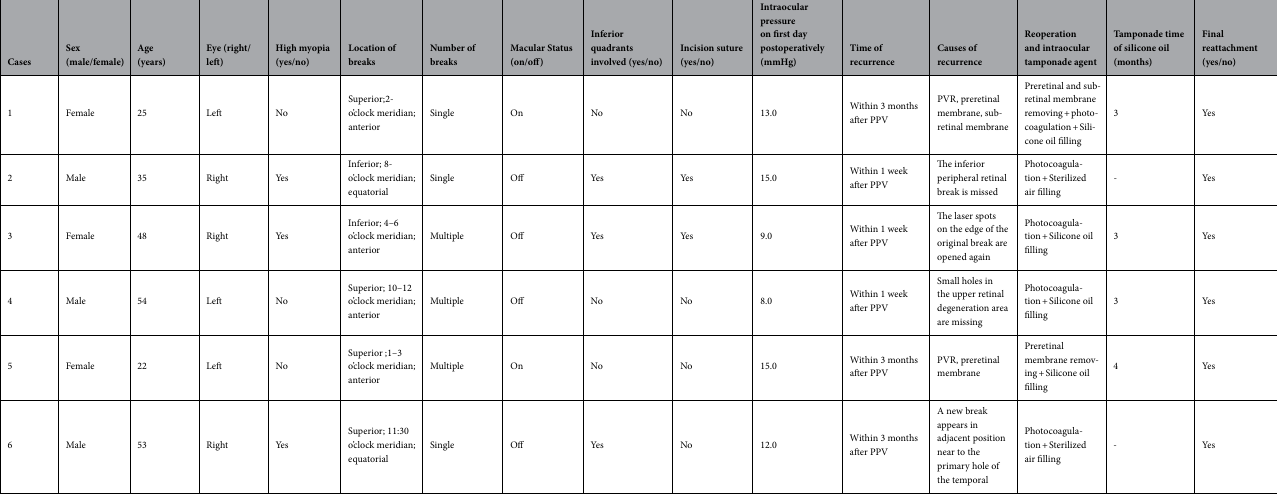
Table 4. Summary of recurrent